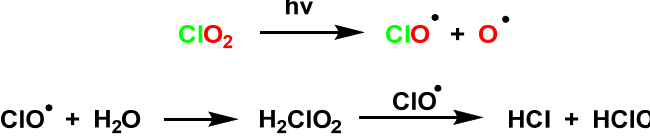
Figure 17. Hydrolysis of XOClO 2 in basic medium to produce ClO 3 − and OX − .